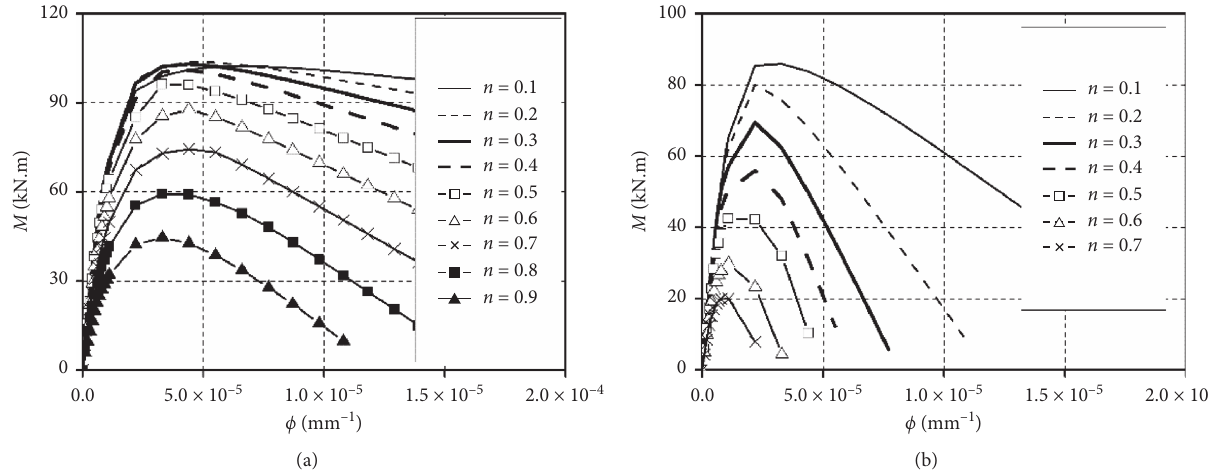
Figure 12: Component-based M - ϕ relation curves. (a) Slenderness ratio of 20. (b) Slenderness ratio of